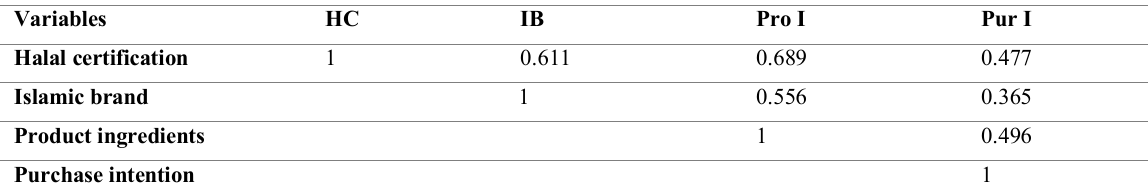
Table 5: Correlation analysis for Indonesia